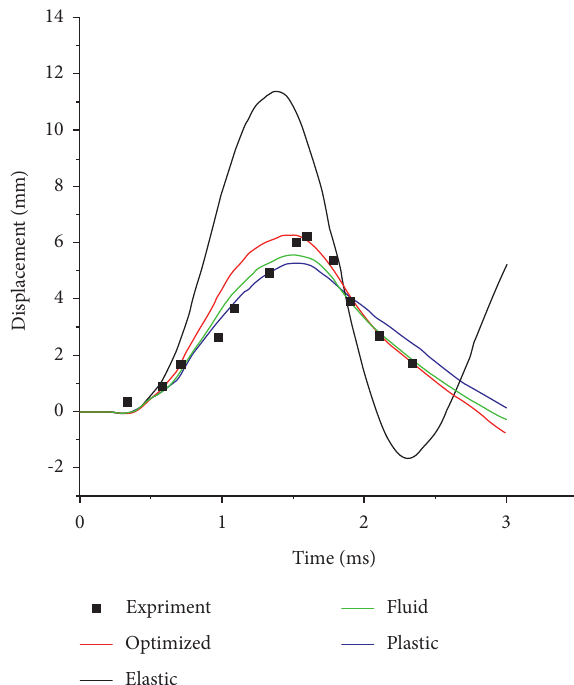
Figure 6: Comparisons of the numerical displacements among different constitutive models.